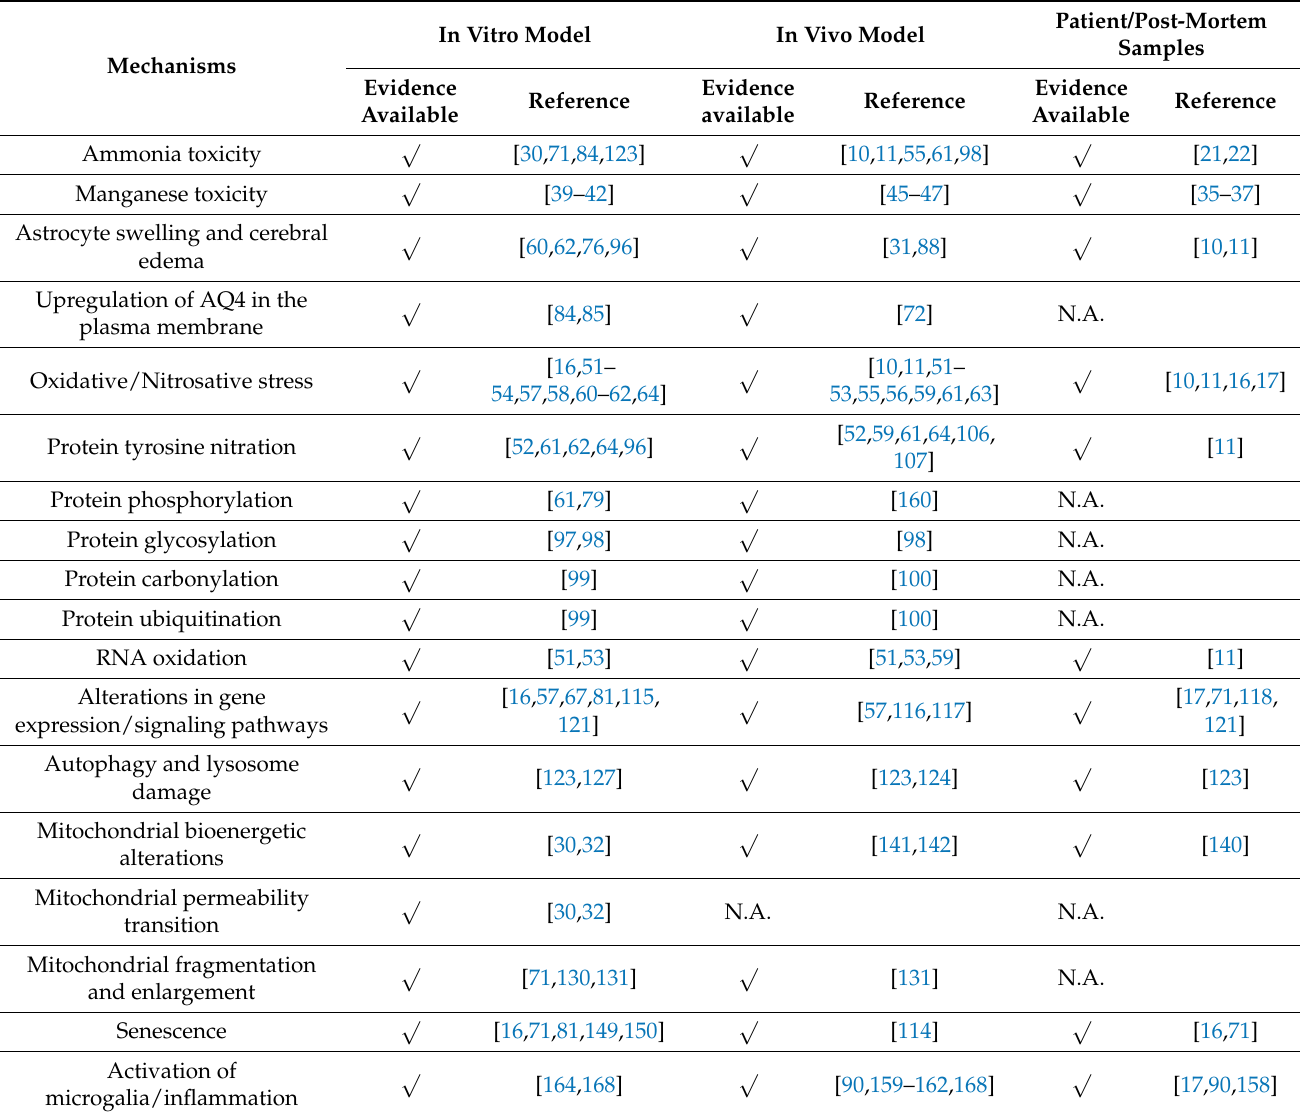
Table 1. An overview of major molecular and cellular pathogenesis mechanisms of hepatic en- cephalopathy and their representative